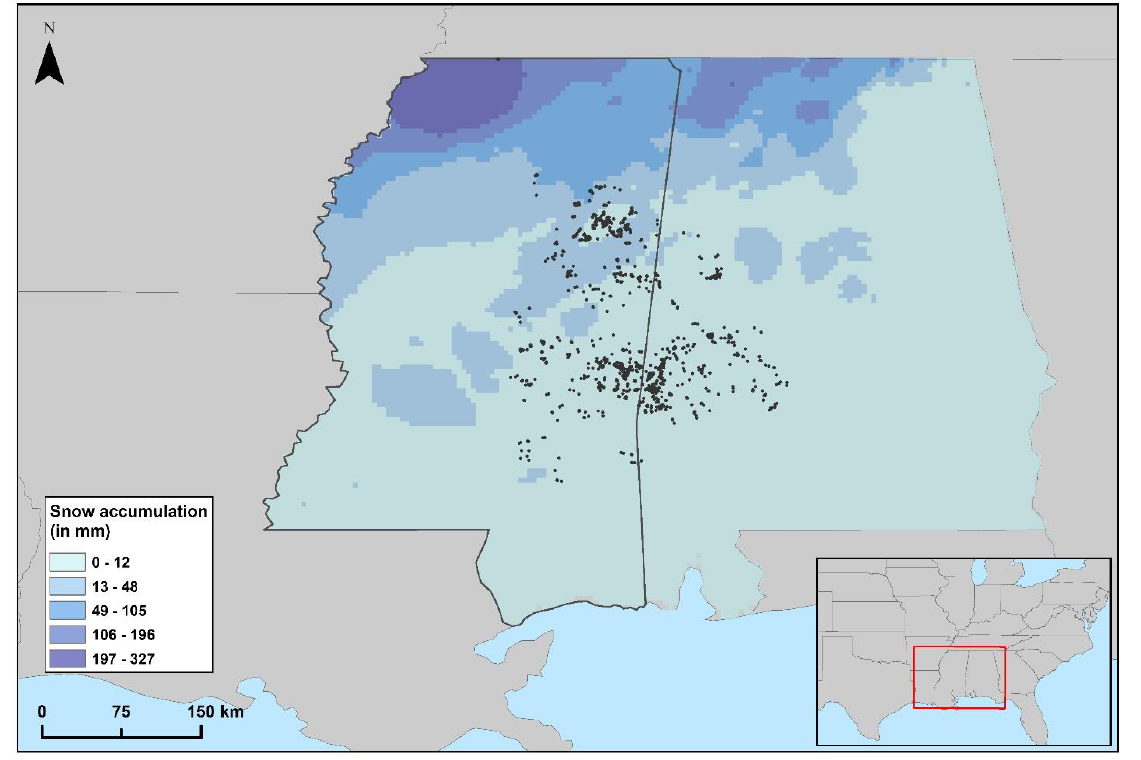
Figure 2. Snowfall accumulation from winter storm Viola between 15 – 20 February 2021.